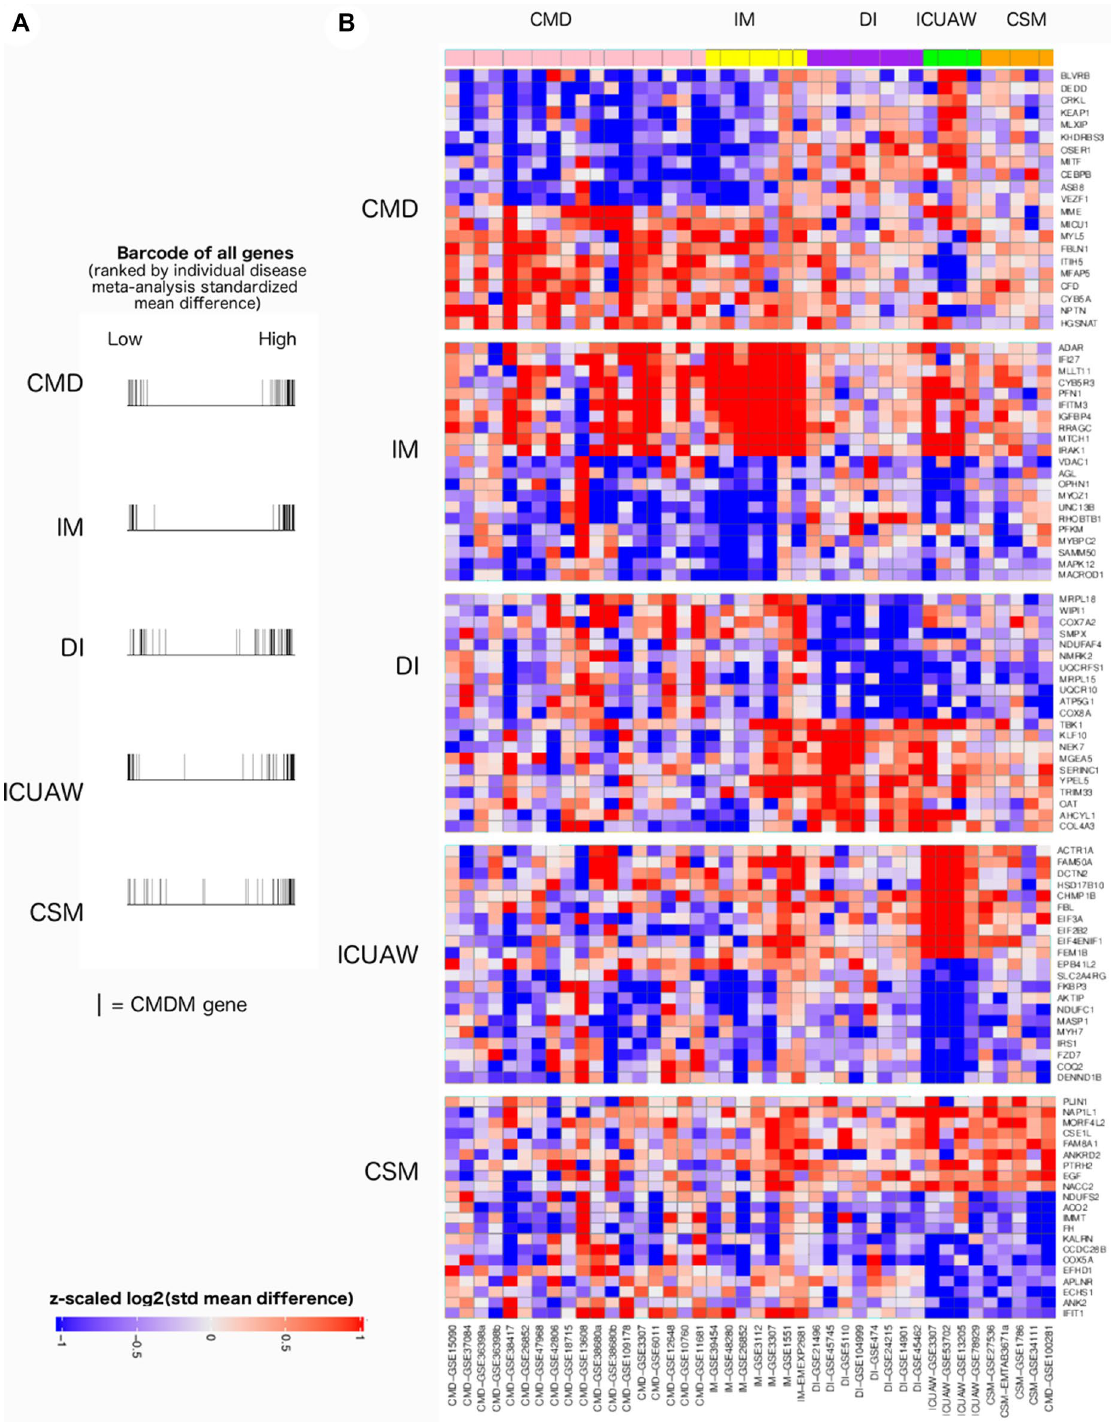
Figure 4. Disease-specific meta-analysis. ( A ) Distribution of the 52 CMD genes among individual disease meta-analysis gene lists. Each line presents the presence of a CMDM gene among the 24,572 gene probes generated from disease-specific meta-analysis ranked from the most positive standardized mean difference (left) to the most negative standardized mean difference (right). ( B ) Disease-specific meta-analysis after removing genes differentially expressed across the other four disease categories, identifies genes more strongly expressed in a single disease. Top 10 up-regulated and top 10 down-regulated genes shown (if 20 or more genes present). ICUAW intensive care unit acquired weakness, IM inflammatory myopathies, DI disuse and immobility, CMD congenital muscle disorders, CSM chronic systemic diseases affecting